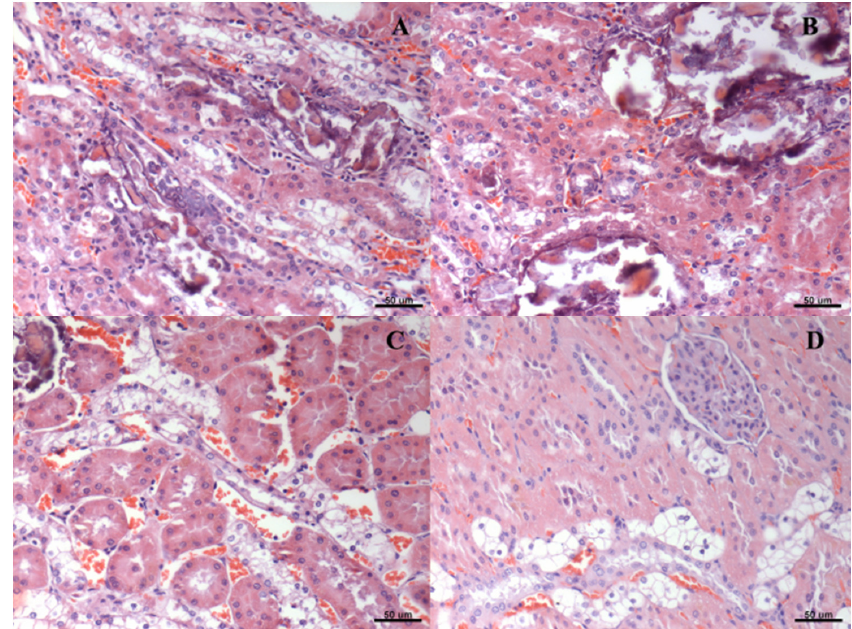
Figure 3. Histological representation (hematoxylin and eosin—20×) of degrees of renal degeneration in type 2 diabetic rats (HFD/STZ) submitted to physical training and/or treated with beta ‐ glucans (30 mg/kg/day). ( A ) diabetes mellitus ; ( B ) diabetes mellitus + beta ‐ glucan; ( C ) diabetes mellitus + exercise; ( D ) diabetes mellitus + beta ‐ glucan + exercise.